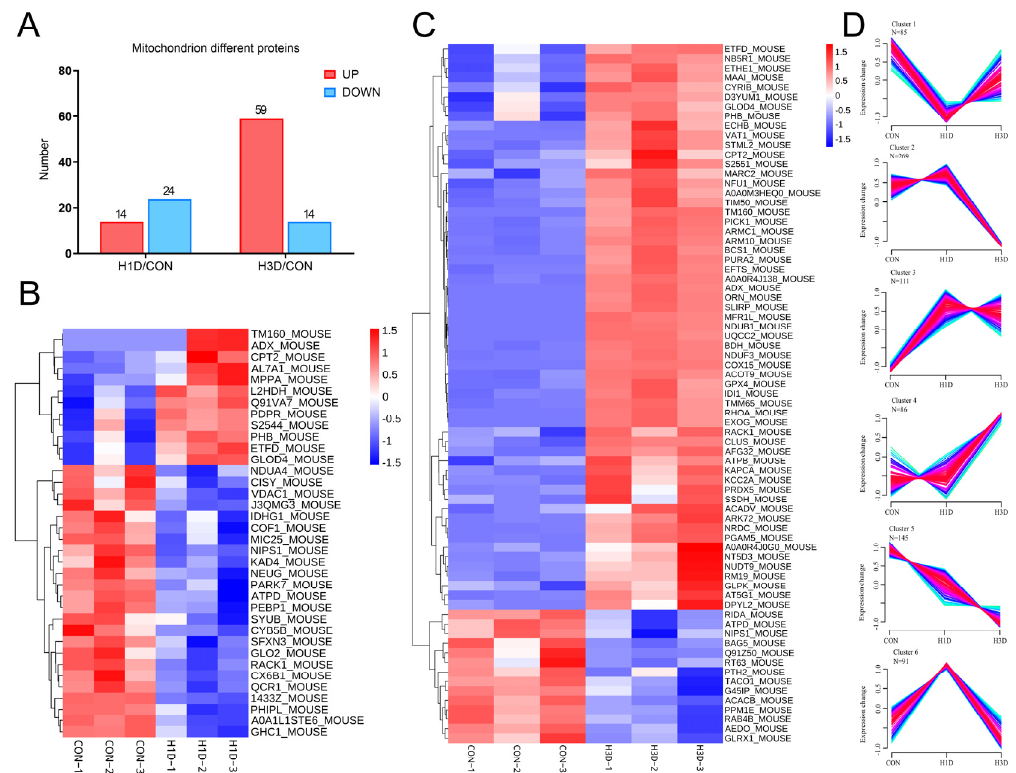
Figure 4. Hypoxic stress mainly caused mitochondrial dysfunction. ( A ) Mitochondrial proteins of interest were considered significantly regulated at p ≤ 0.05 and a fold change ≥ 1.2 or ≤ 0.67. ( B , C ) Heat map showing the prominent different mitochondrial proteins in H1D ( B ) and H3D ( C ) mice compared with the CON. ( D ) Unsupervised clustering of proteome dynamics revealed six clusters with mitochondrial protein expression profiles: n represents the number of proteins per cluster. The color represents memberships. The red represents more memberships, the blue and green low memberships.